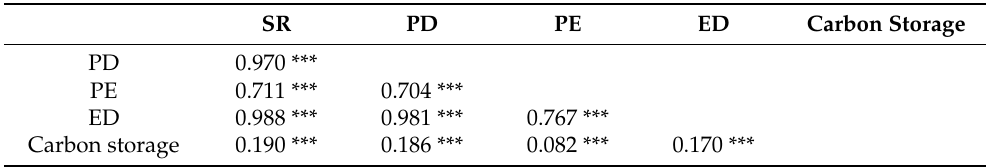
Table 1. Pearson’s correlation coefficient matrix between species richness (SR), phylogenetic diversity (PD), phylogenetic endemism (PE), evolutionary distinctness (ED) and carbon storage ( n = 3805). p -values are represented as *** p < 0.001.